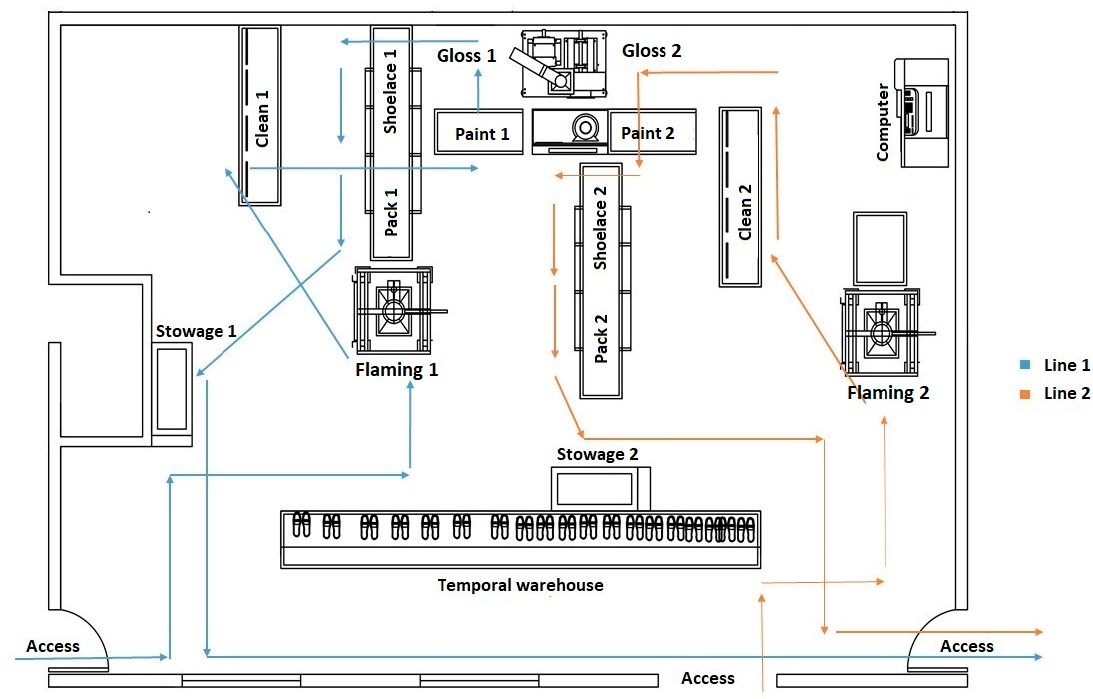
Figure 6. Flow of the current process elaborated by the author based on what was observed in the